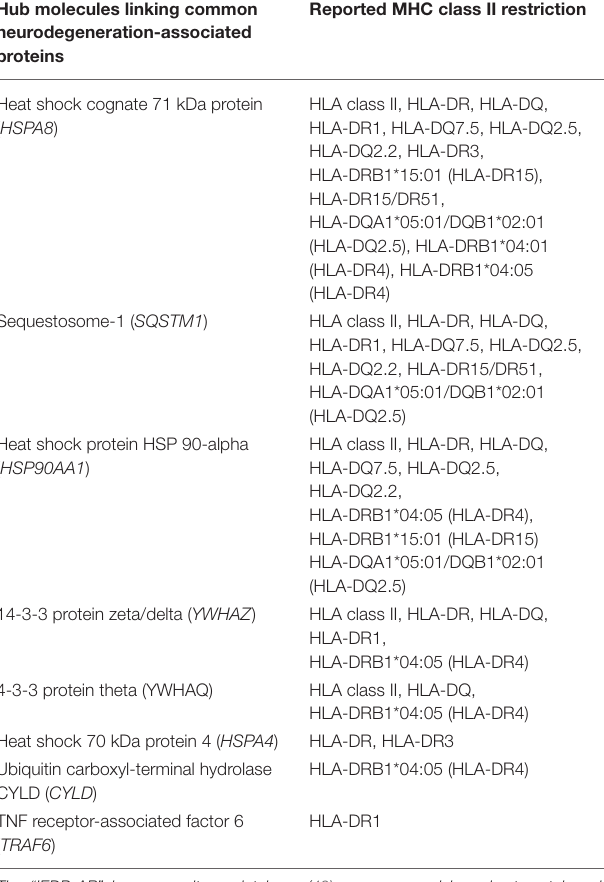
TABLE 5 | List of the main hub partners linking neurodegeneration-associated proteins and giving rise to MHC class II-binding endogenous peptides in the human B-cell lineage.